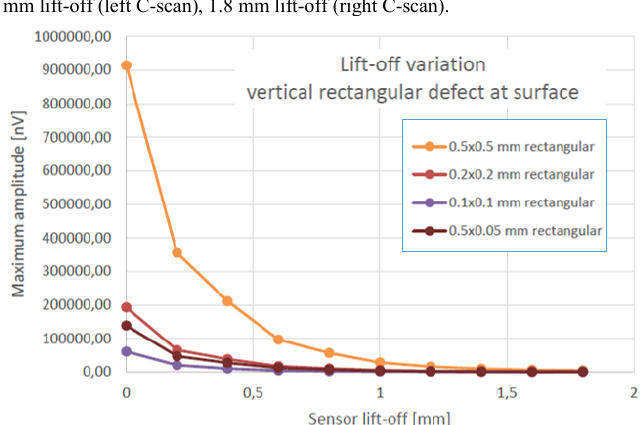
Fig. 16. Eddy current maximum amplitudes in lift-off variation simulations (defect width=0.1 mm).